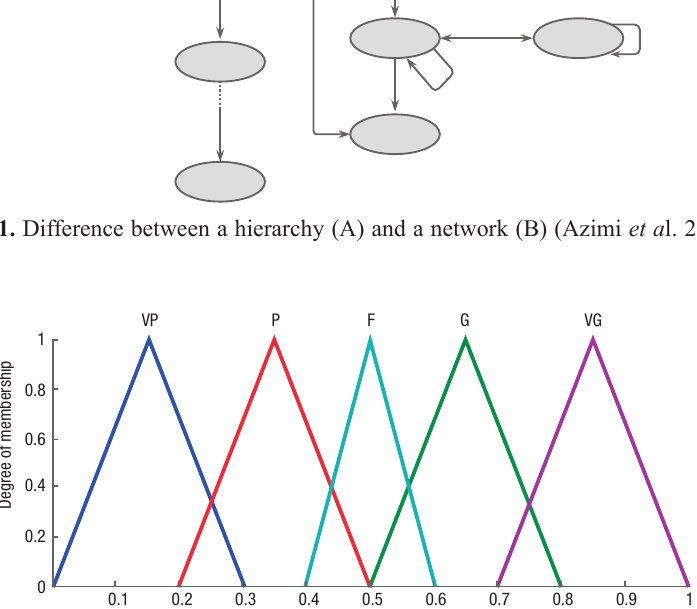
Fig. 2. Membership function of linguistic variables for preference